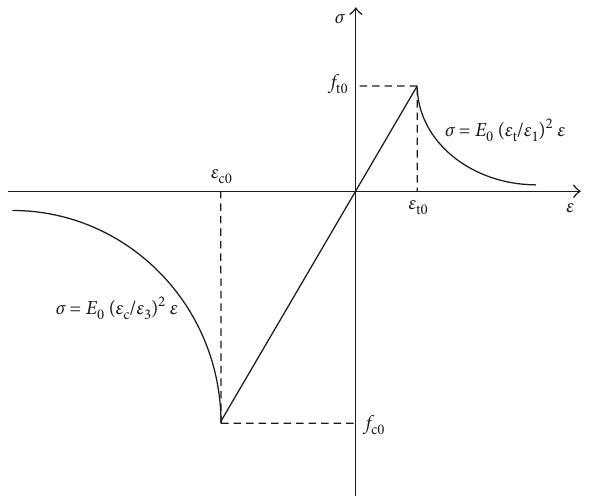
Figure 2: The damage constitutive criterion of elements under uniaxial stress